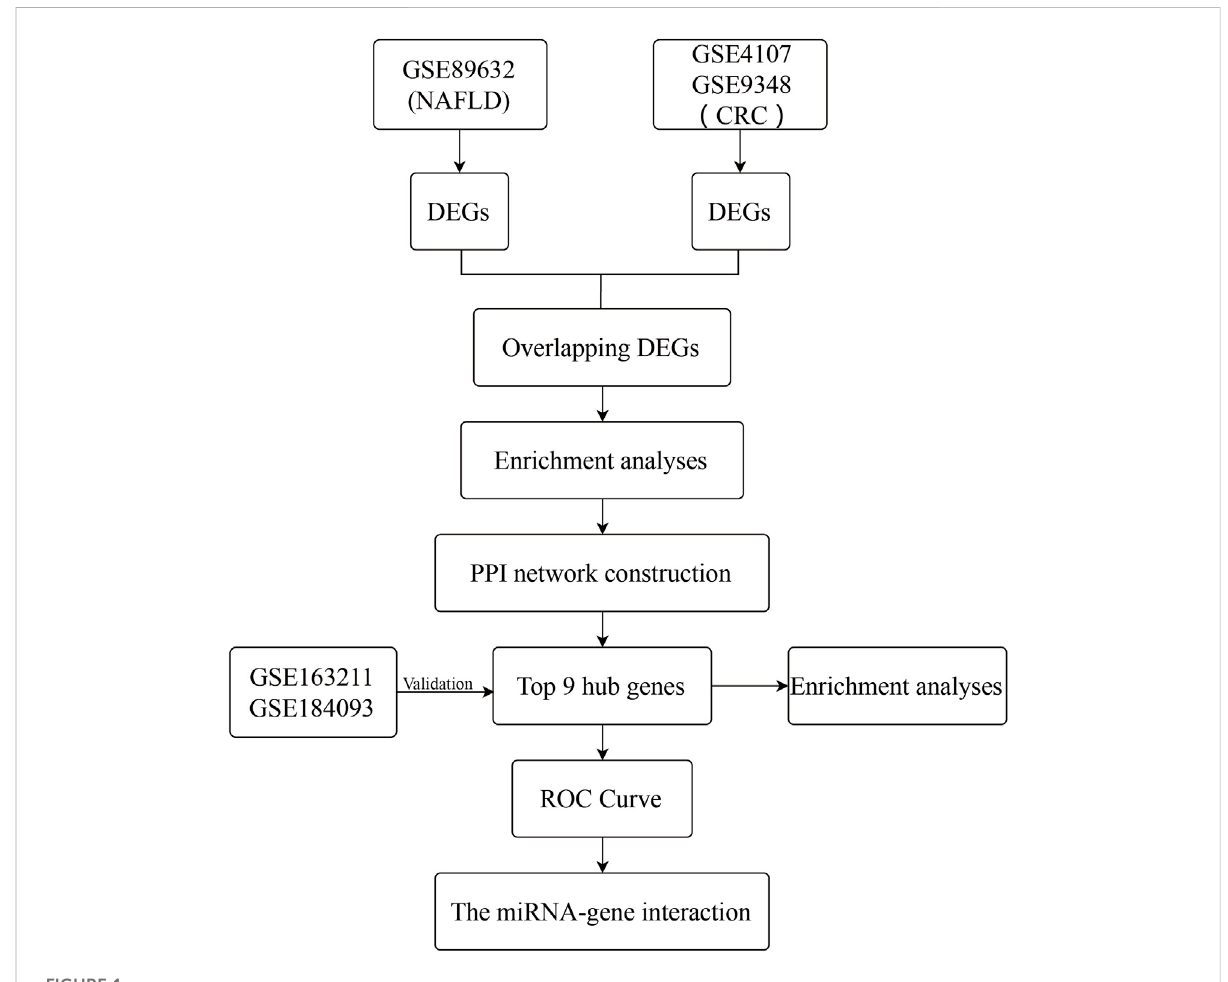
FIGURE 1 The speci fi c fl ow map of this